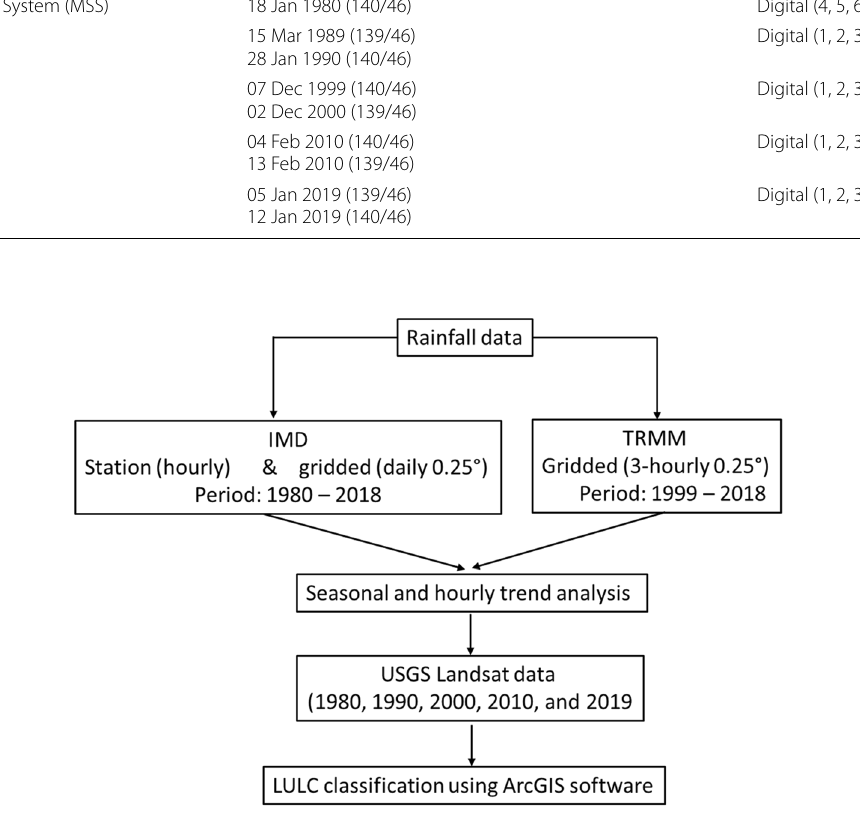
Fig. 2 Flowchart of methodology